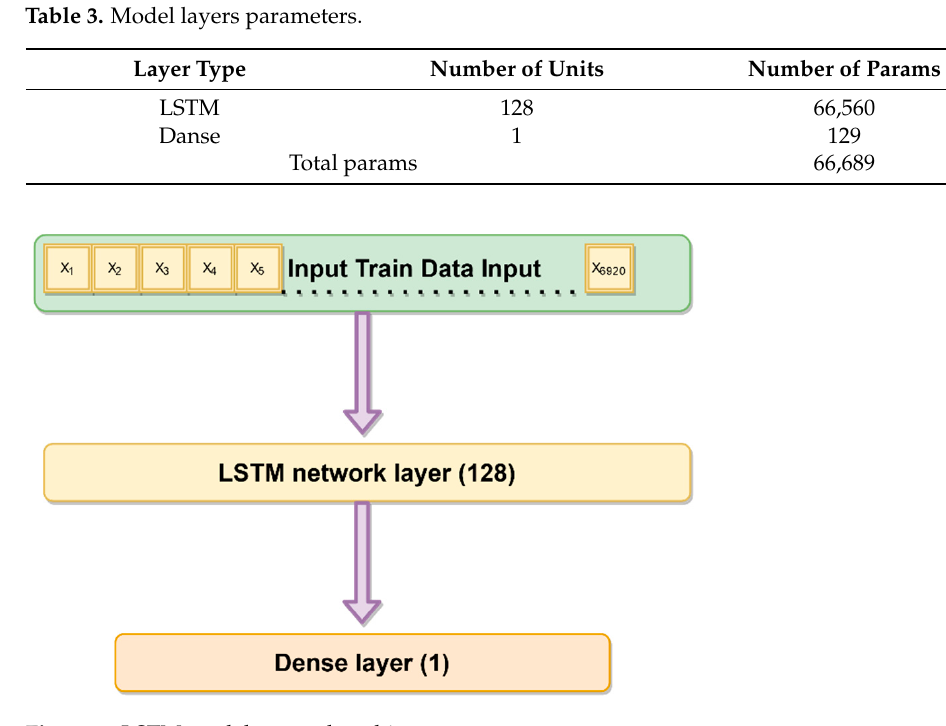
Figure 2. LSTM model network architecture.